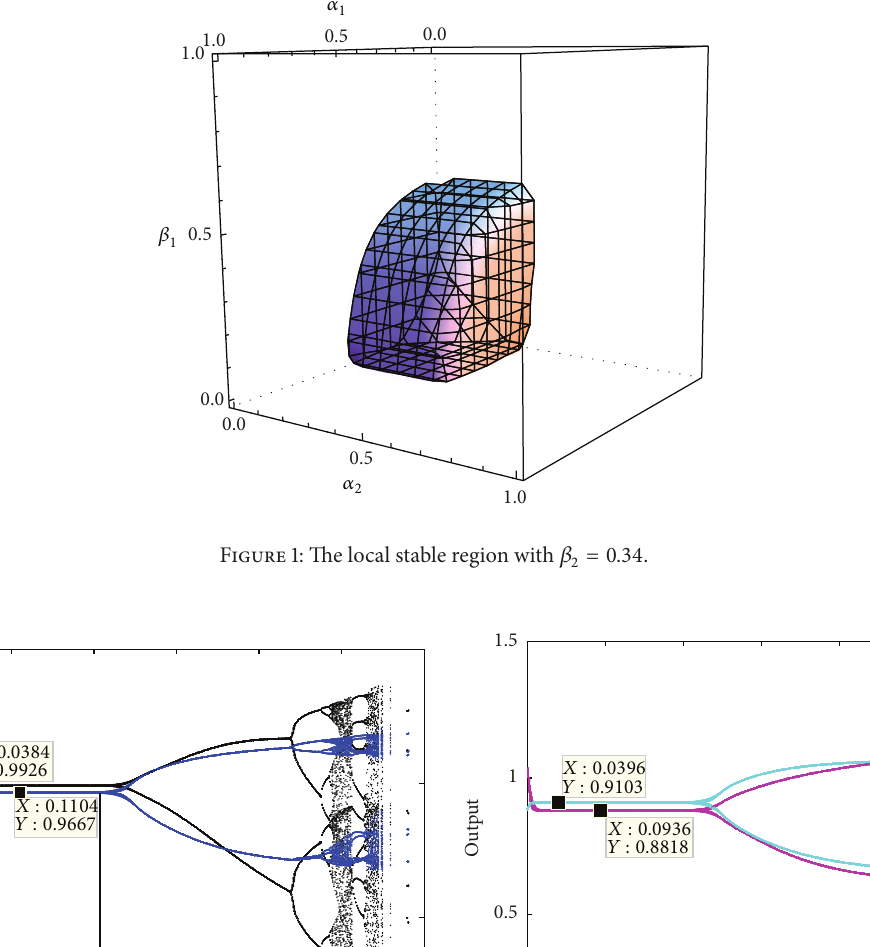
Figure 4(a) is time series curves of 𝑞 1𝑎 when 𝛼 1 =